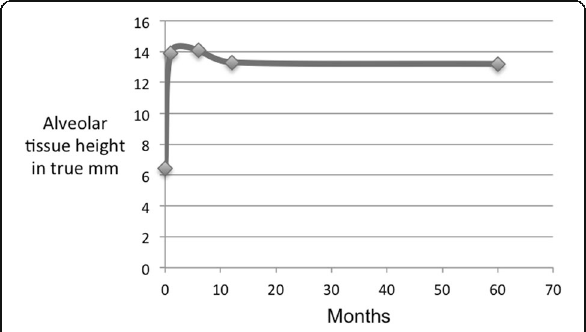
Fig. 2 Aveolar tissue height (in true mm) over a 5-year period in the 9-month group